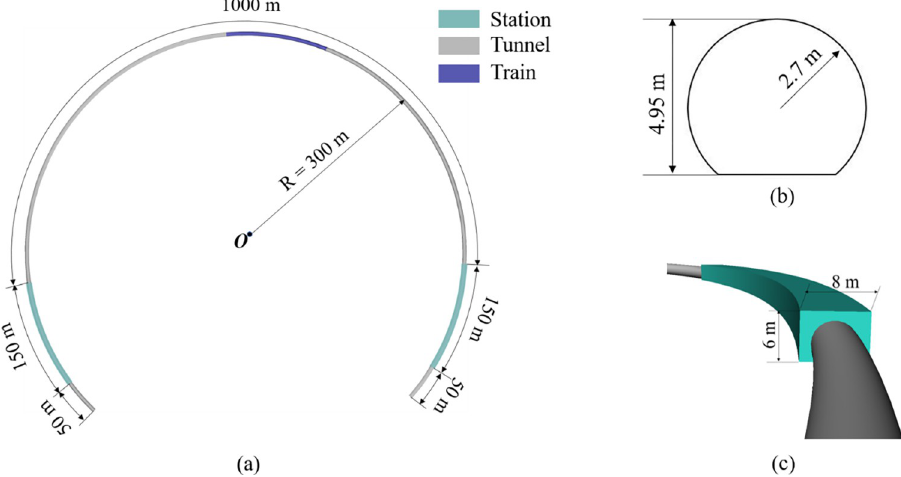
Fig 2. Geometric model of the tunnel. (a) Overall top view; (b) section of tunnel; (c) station